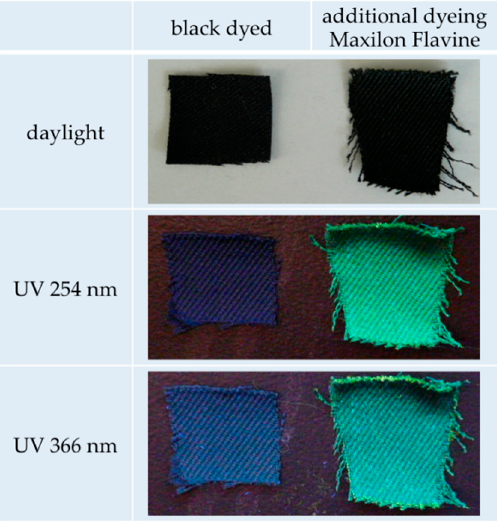
Figure 8. Fluorescent properties of a pre-dyed m-aramid fabric after additional dyeing with a fluorescent dyestuff in EMIM-EtSO 4 .